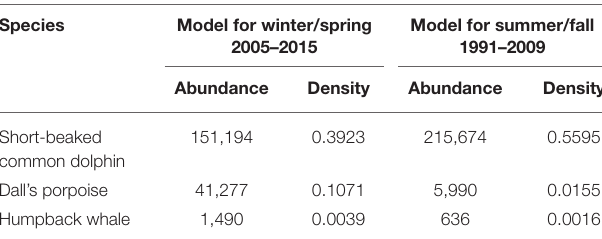
TABLE 3 | Abundance and density estimates derived from habitat-based models for winter/spring (January–April; this study) and for summer/fall (July–November) by Becker et al. (2016) based on line-transect survey data collected during seven systematic ship surveys conducted from July to November between 1991 and